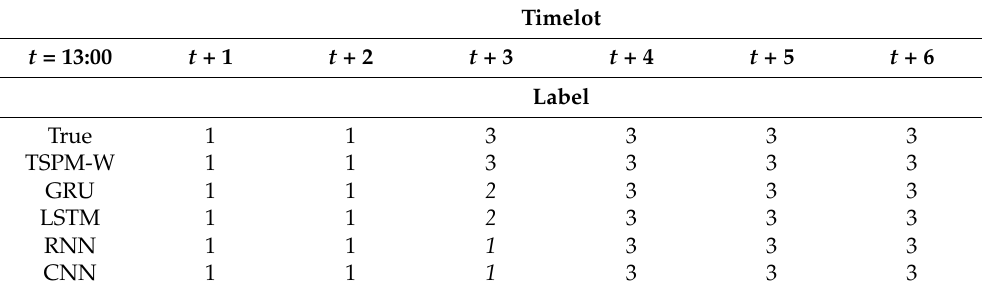
Table 10. Traffic situations’ prediction (Feature combination 2) for 29th November 2018 13:00 to 19:00.